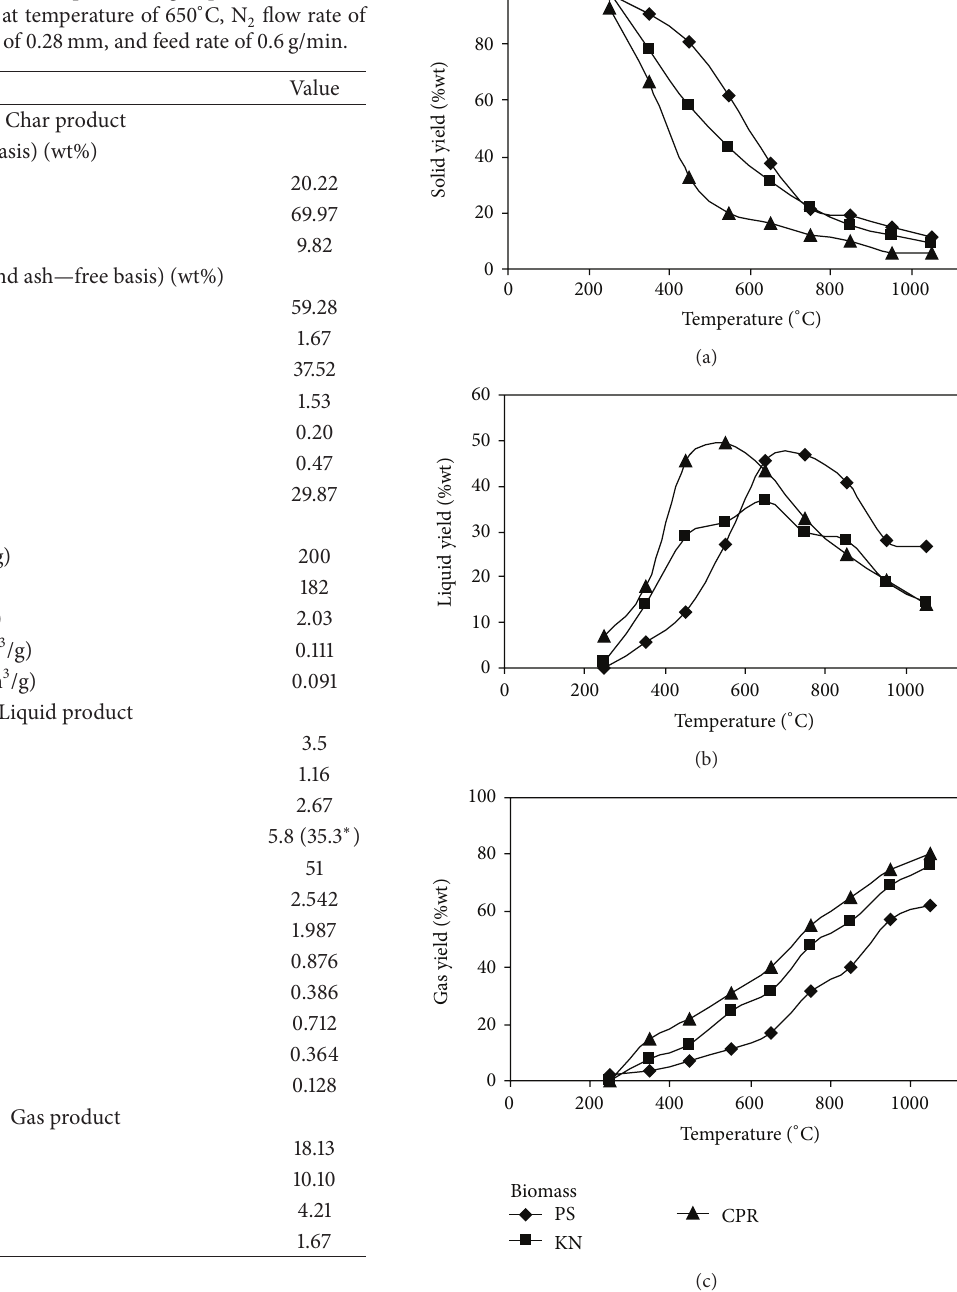
Table 3: Properties of chars, liquid, and gas products derived from palm shell pyrolysis at temperature of 650 ∘ C, N